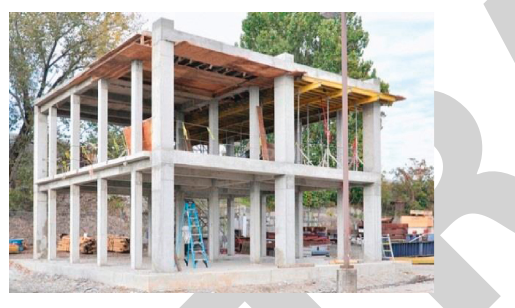
Figure 2: NEES frame structure. This figure is reproduced from [25] (under the Creative Commons Attribution License/public domain).